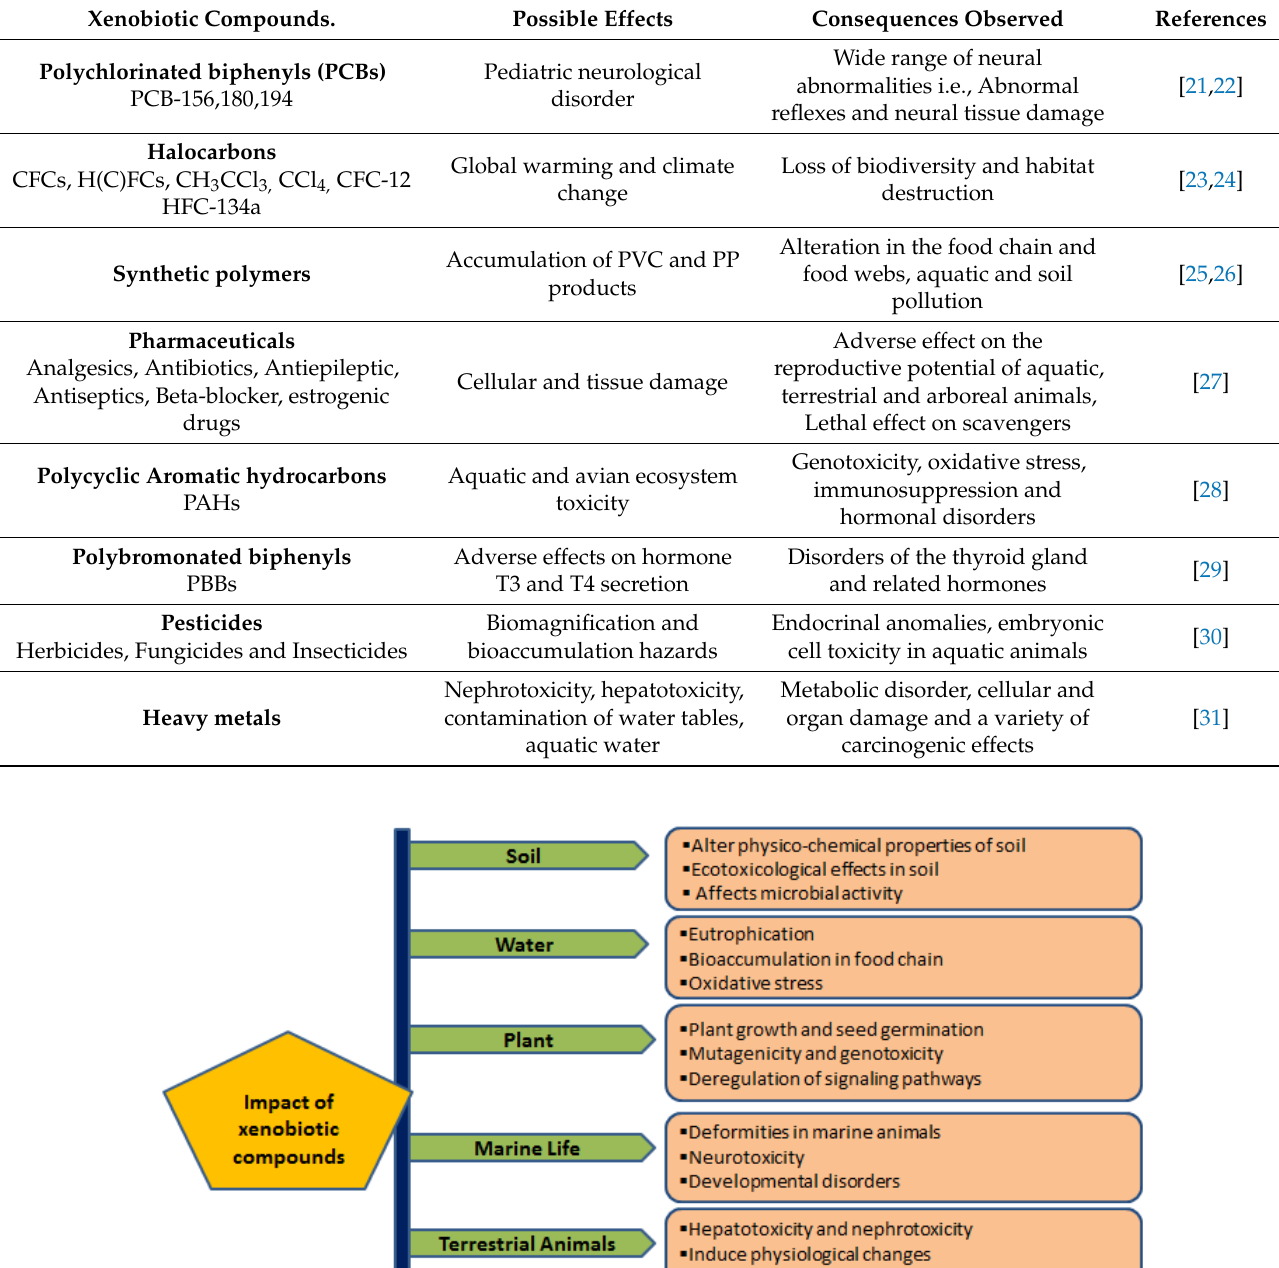
Table 1. Major xenobiotic compounds and their effects.